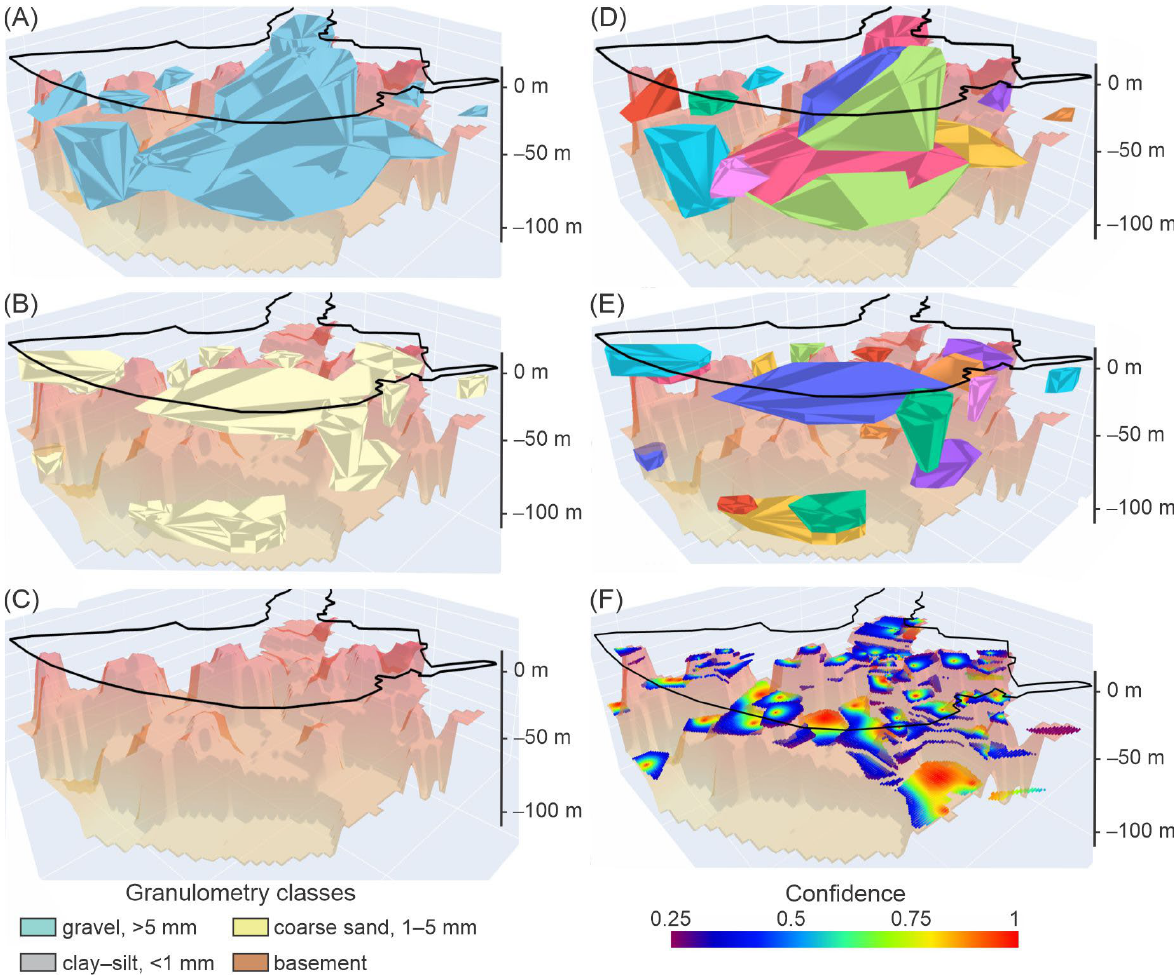
Figure 6. The 3D stratigraphic architecture (essential stratigraphic elements of hydrogeological interest and their confidences) in the LRD. ( A − C ) The KNN algorithm predictions [18] for gravel sedimentary bodies (or lithosomes) (>5 mm, cyan) and the basement’s top surface (BTS) ( A ), coarse sand sedimentary bodies (1–5 mm, yellow), the only BTS ( B ) and BTS (brown) ( C ). In Supplementary Materials, an interactive 3D version of this model can be found (3D_Lithosomes_And_Base- ment_LRD.html). ( D − F ) The corresponding KNN prediction confidences, expressed in the dimen- sionless 0.25–1 range, for gravel sedimentary bodies ( D ), coarse sand sedimentary bodies ( E ) and